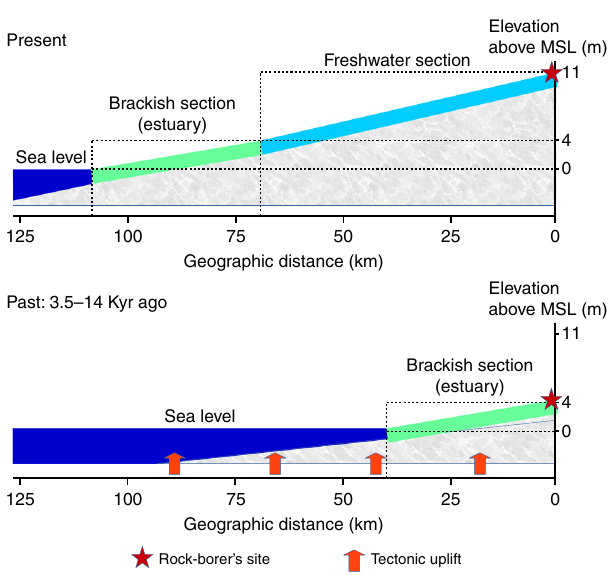
Fig. 2 Model of neotectonic evolution of the lower course of the Kaladan River. The long-term uplift rate R of 0.5 – 2 mm/year was applied (see Methods section). The model assumes a gradual shift from estuarine to freshwater environment at the rock-borer ’ s site due to the tectonic uplift with subsequent adaptation of the population of the brackish rock-boring species Lignopholas fl uminalis to freshwater habitat. (Model: Ivan N. Bolotov, Mikhail Yu. Gofarov, Yu Wang, & J. Bruce H.